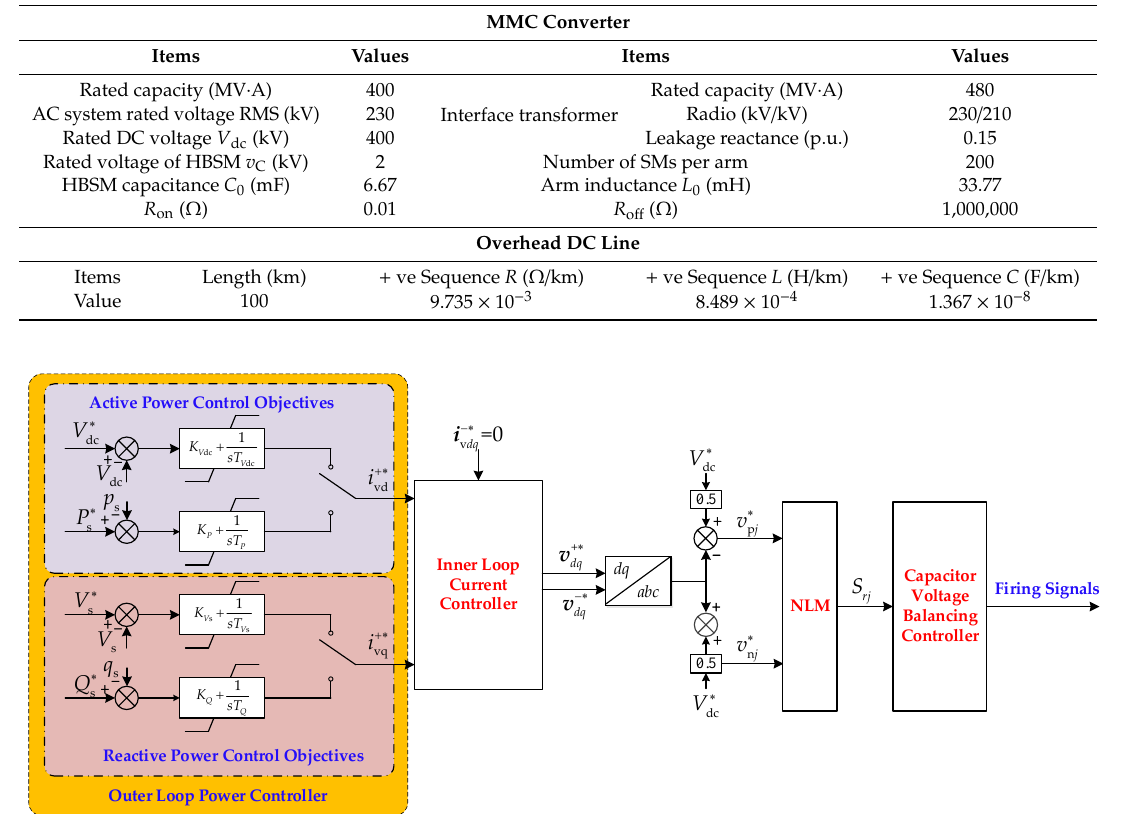
Table 2. The parameters of the MMC-HVDC.